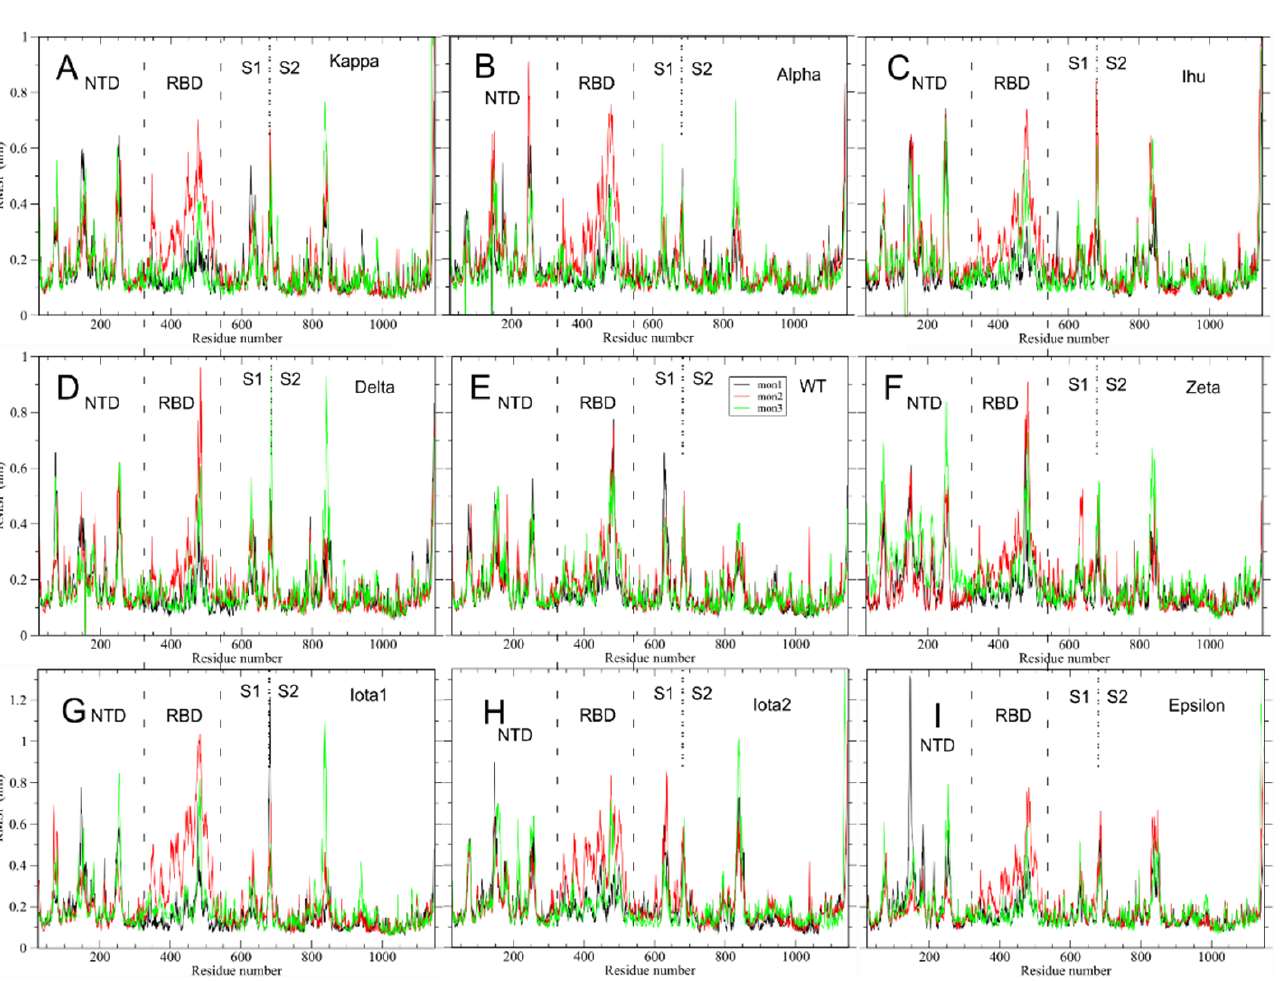
Figure 5. Per-residue RMSF in SARS-CoV-2 ( A ) Kappa, ( B ) Alpha, ( C ) Ihu, ( D ) Delta, ( E ) WT, ( F ) Zeta, ( G ) Iota1, ( H ) Iota2, ( I ) Epsilon systems. The three S monomers are colored in black, red, and green, respectively. Monomer 2 is in an up conformation (see Section 4). The NTD and RBD regions are highlighted with dashed lines. The S1/S2 boundary at residue 681 is highlighted with a dotted line.